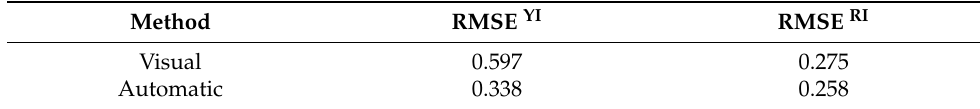
Table 12. RMSE values based on analysis of the data obtained.